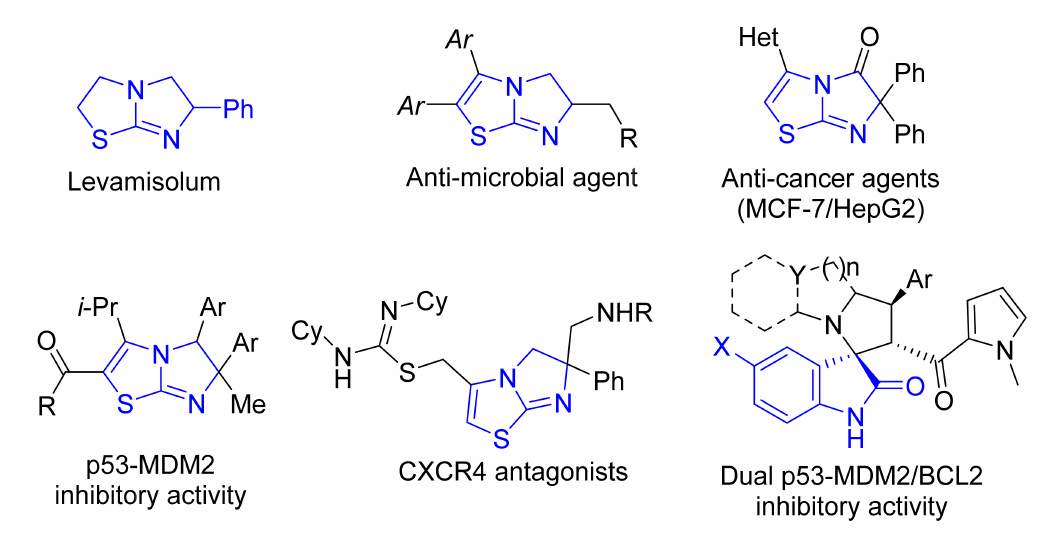
Figure 1. Representative examples of biologically active compounds having imidazothiazole and spirooxindole